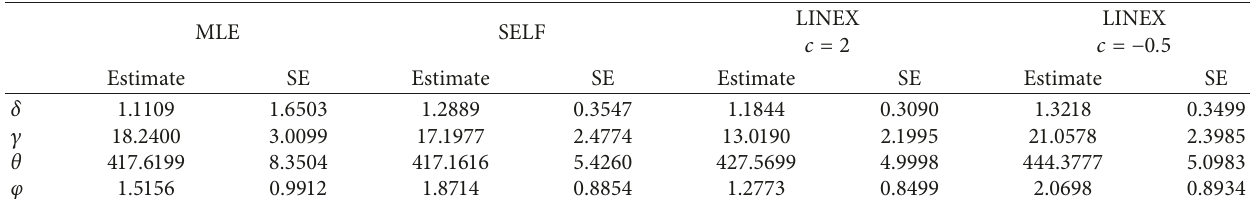
Table 11: Estimation methods for IELoP distribution for dataset